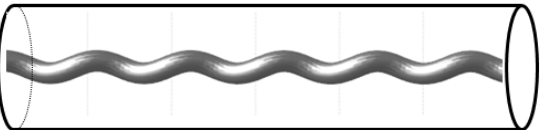
Figure 10. Schematic of the fiber structure after twisting in the oven. Adapted with permission from Ref. [18] © The Optical Society.